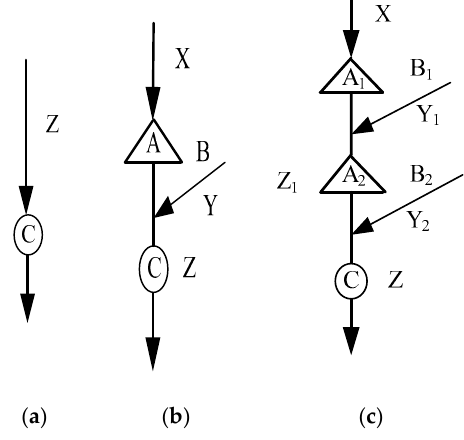
Figure 1. Sketch diagrams of natural condition and flood control system. ( a ) Natural condition; ( b ) Single reservoir; and, ( c ) Cascade reservoirs.